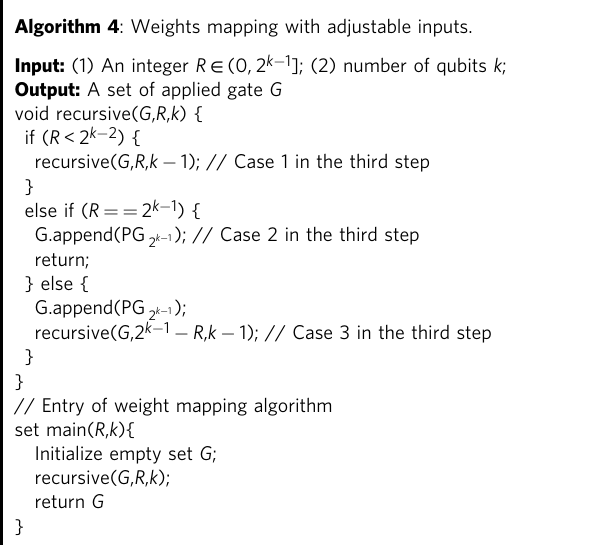
Fig. 6f. In this circuit, ~ z 0 ¼ z ´ sin 2 g ð θ ; γ Þ will have ~ z ¼ z ´ sin 2 θ that g ð θ ; γ Þ ¼ 2 ´ arcsin ð sin θ